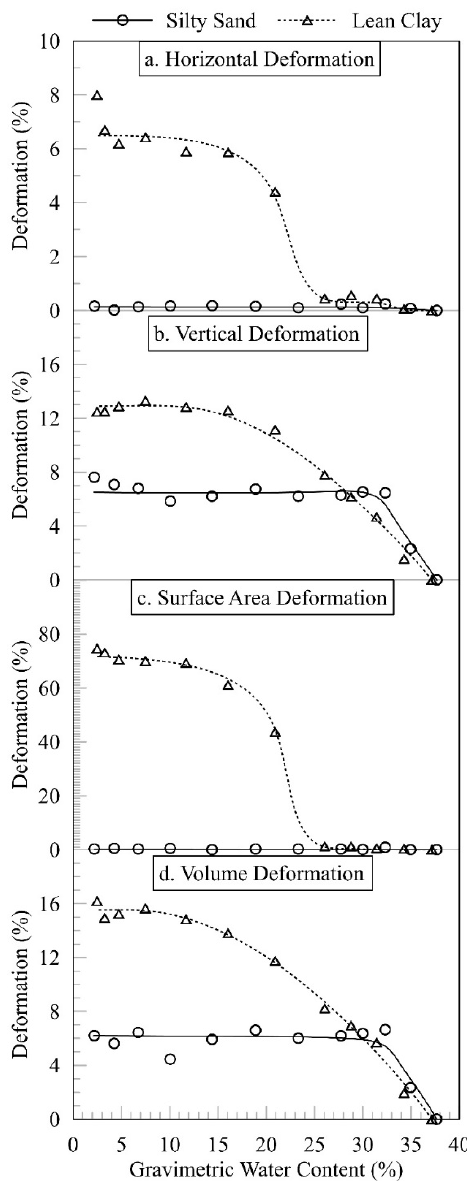
Figure 5. Deformations during drying under low demand for silty sand and lean clay: ( a ) horizontal deformation; ( b ) vertical deformation; ( c ) surface area deformation; ( d ) volume deformation.